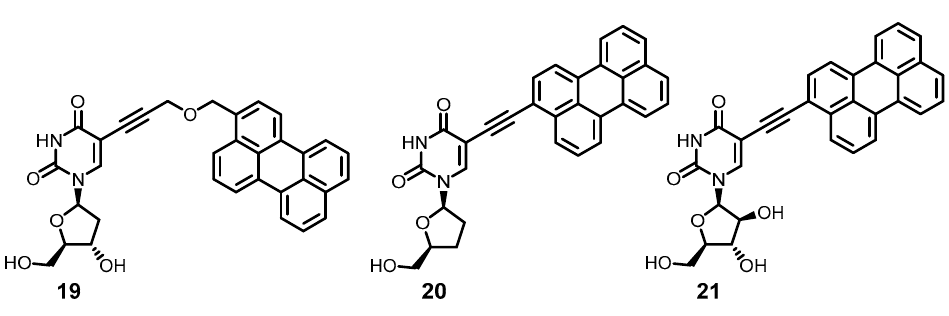
Figure 6. Perylene-based RAFIs.